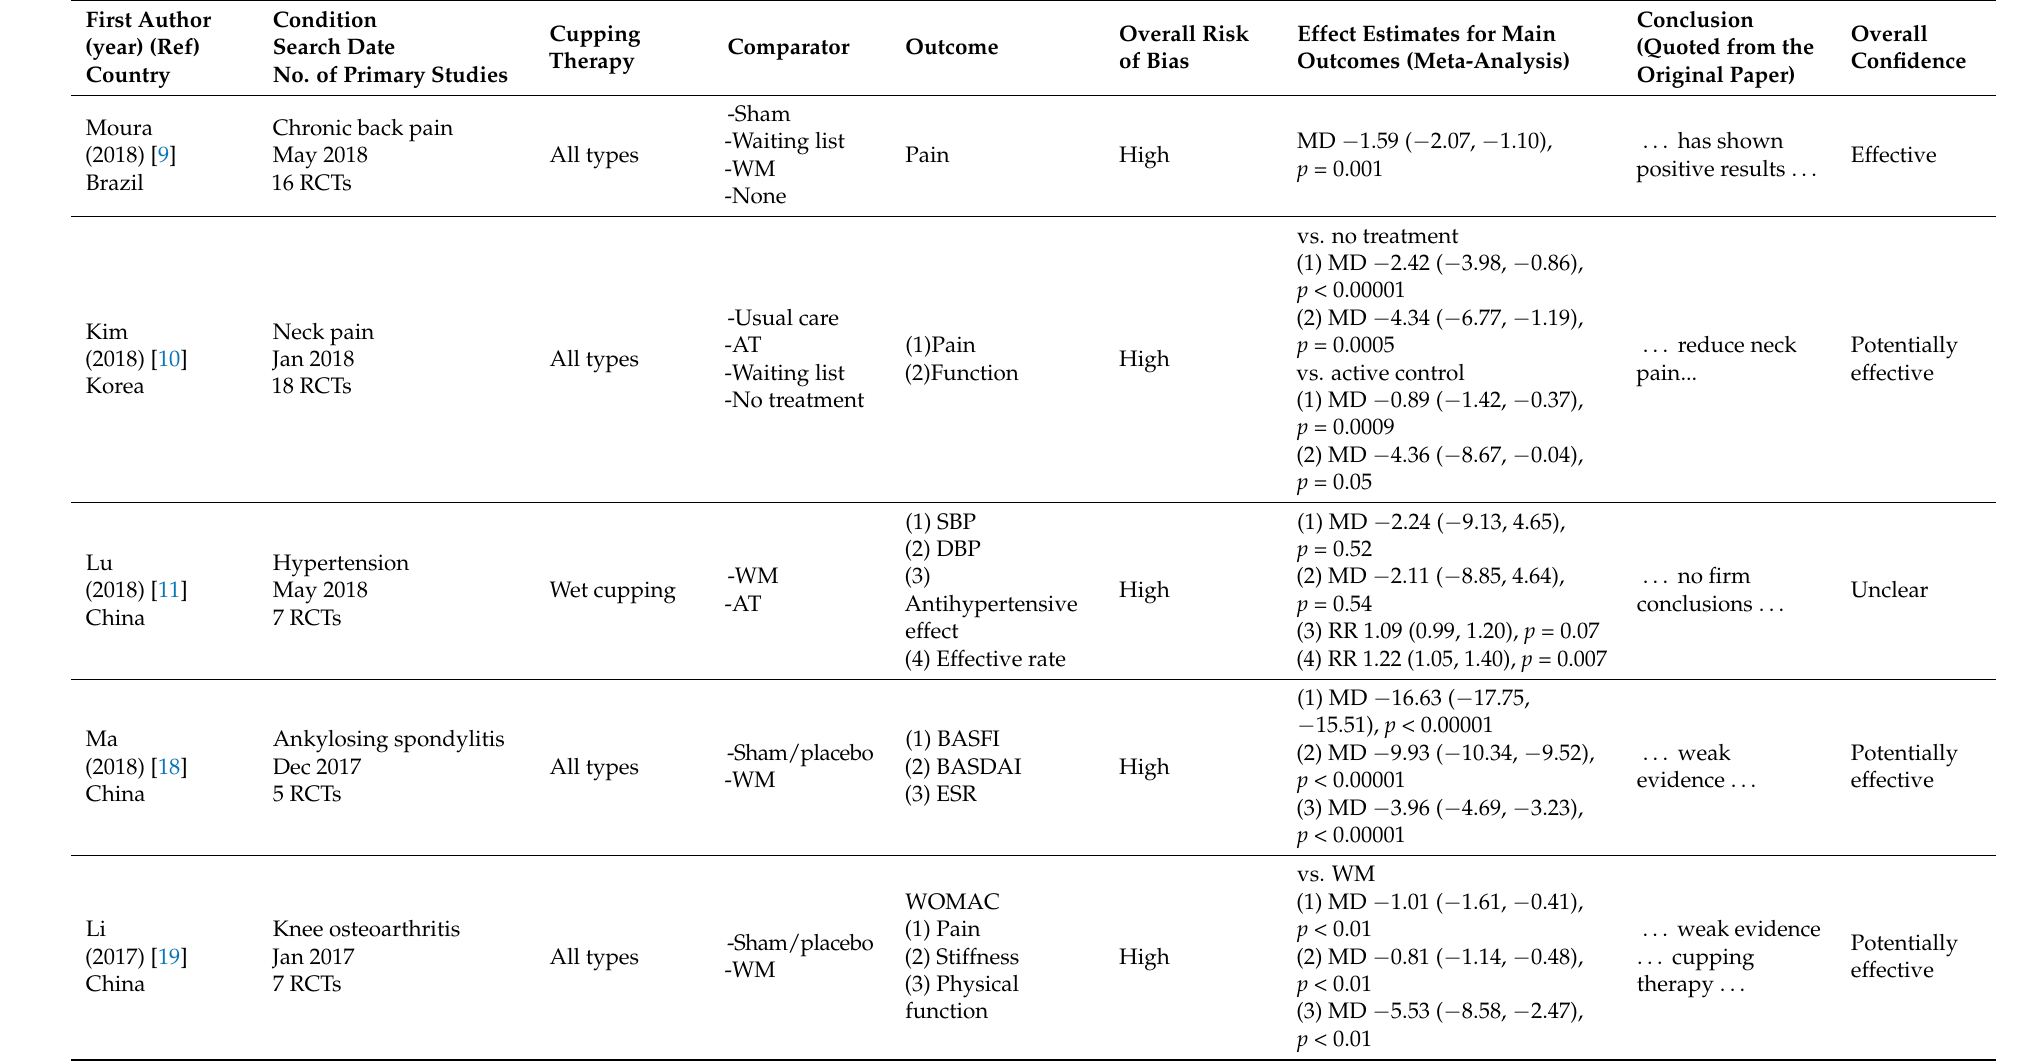
Table 1. Summary of the included systematic reviews of cupping